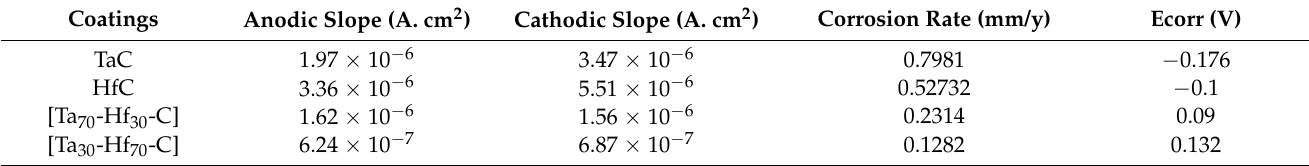
Table 3. Values of Tafel polarization curves.